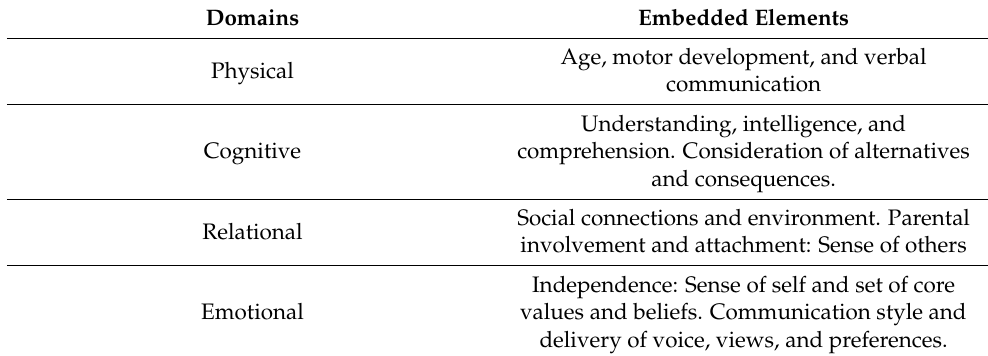
Table 1. Main domains and elements of children’s capacity.